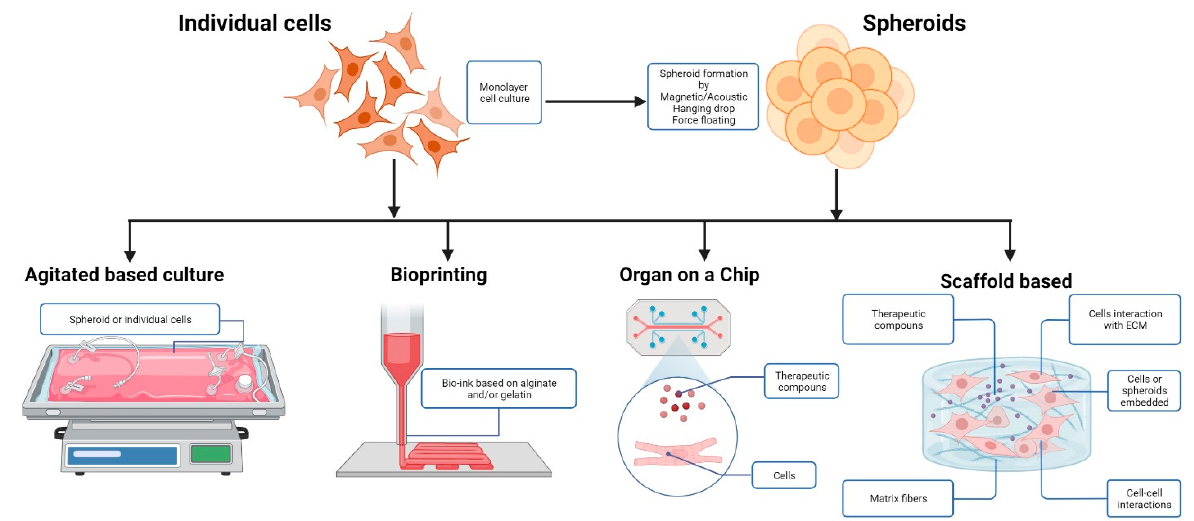
Figure 2. Organoid/spheroid production methods. 3D RA models, starting from 2D cell cultures, could obtain spheroids, non-adherent cell cultures, 3D bioprinting, or embedded cultures describing different aspects of the same pathology.